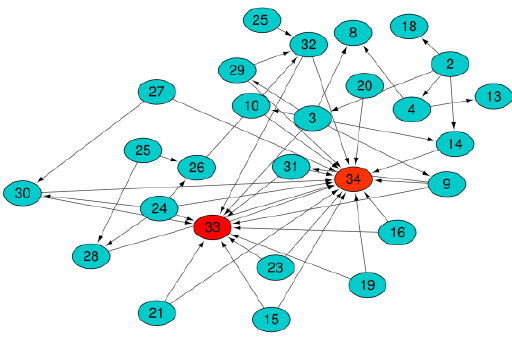
Figure 1. User trust network.